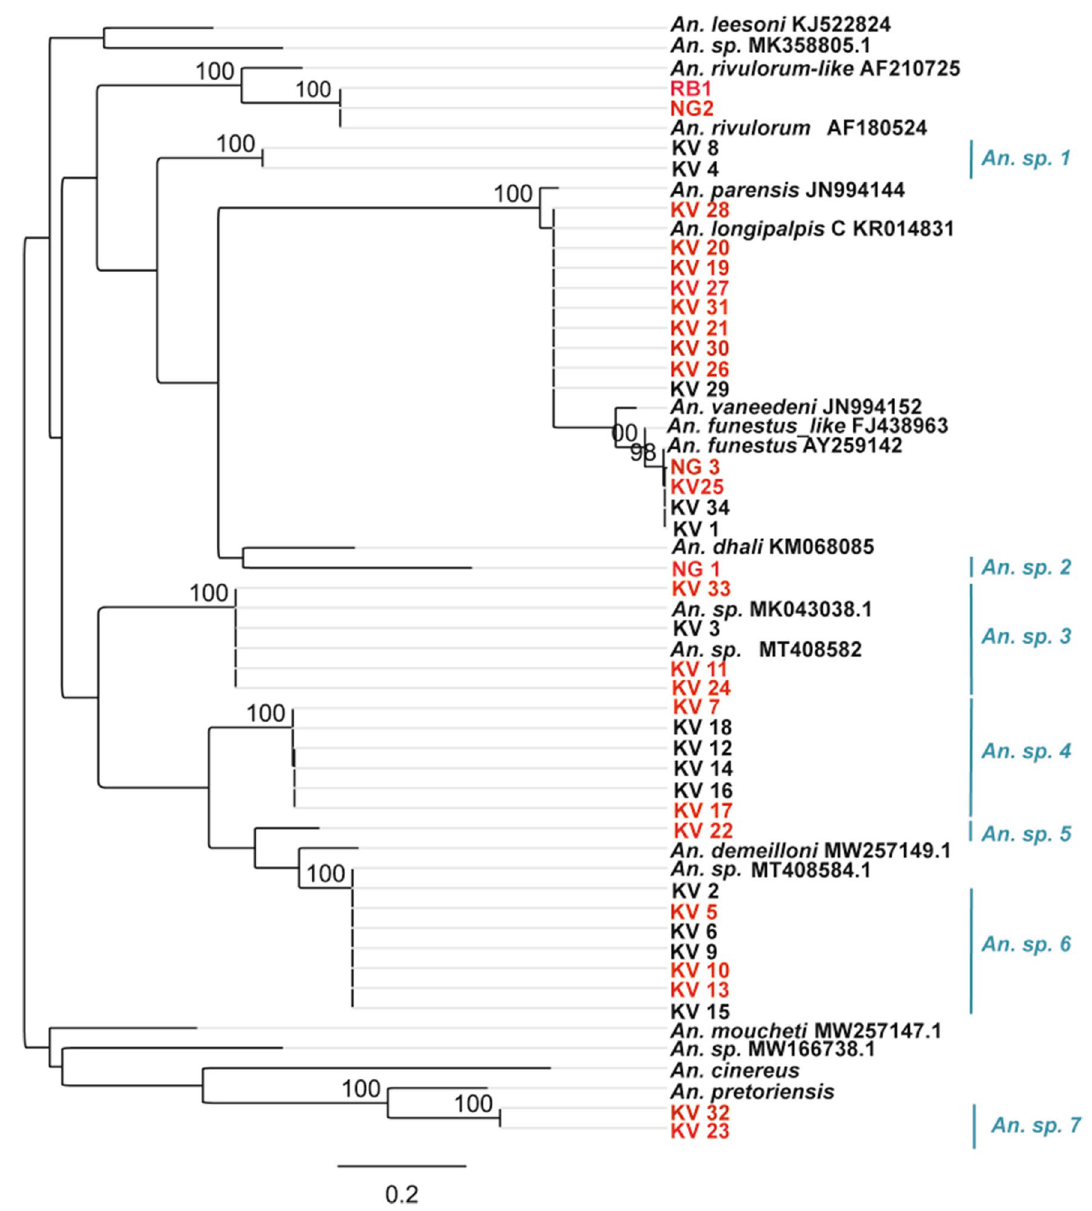
Figure 3. Phylogenetic tree for represetative mosquitoes morphologically scored as An. funestus group infected with P. falciparum sprozoites. Few samples negative for the malaria parasite are also included. Bootstrap support values are indicated above the nodes from 1000 replicates. Highlighted in red are the infected